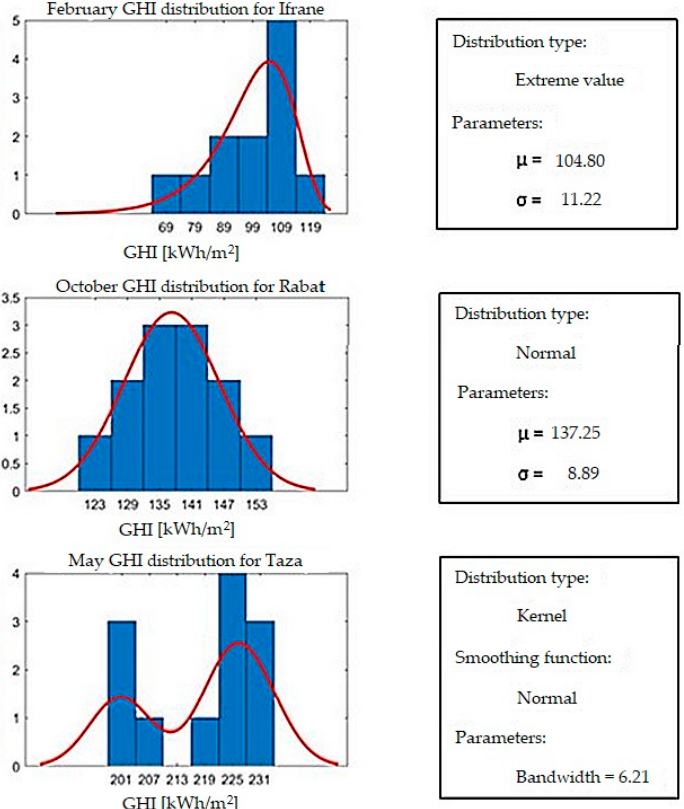
Figure 12. Examples of the extreme value, normal and kernel PDFs’ fitting test results for the month of February in Ifrane, the month of October in Nador and the month of March in Tetouan (GHI case). Source: own